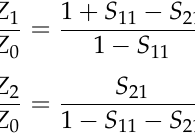
( a ) ( b ) ( c ) ( d ) Figure 6. Surface current distributions with different phases for RHCP: ( a ) 0°, ( b ) 90°, ( c ) 180°, and ( d ) 270°.